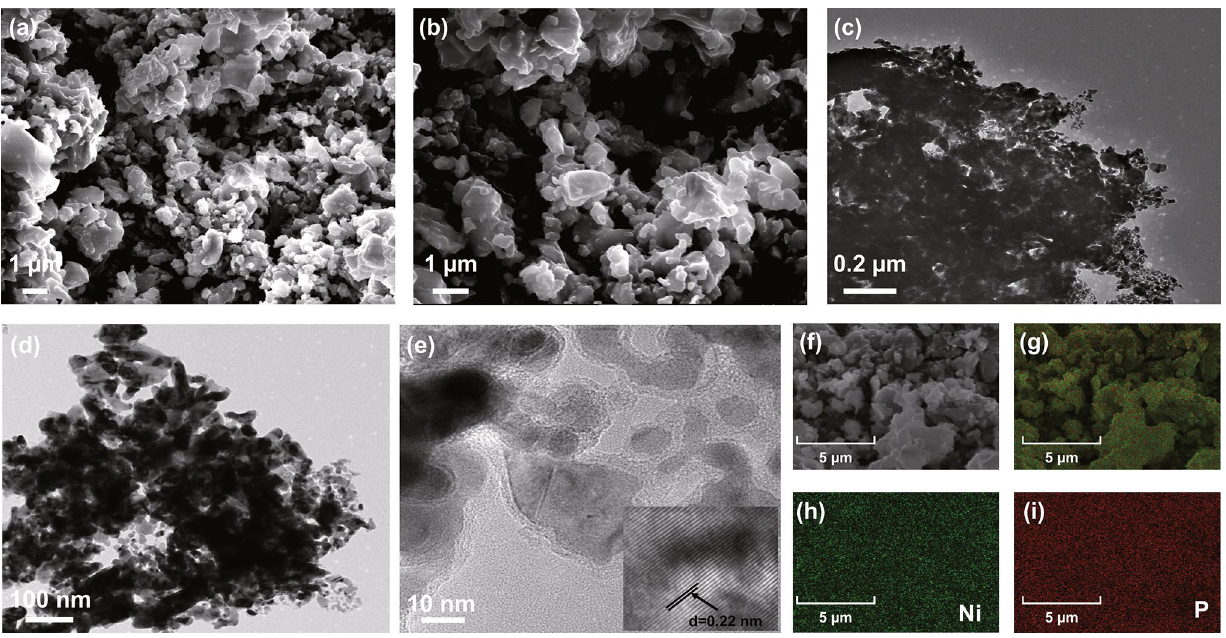
Fig. 8 a , b SEM images, c–e TEM and HRTEM images, and f Corresponding Ni 2 P‑2 elemental